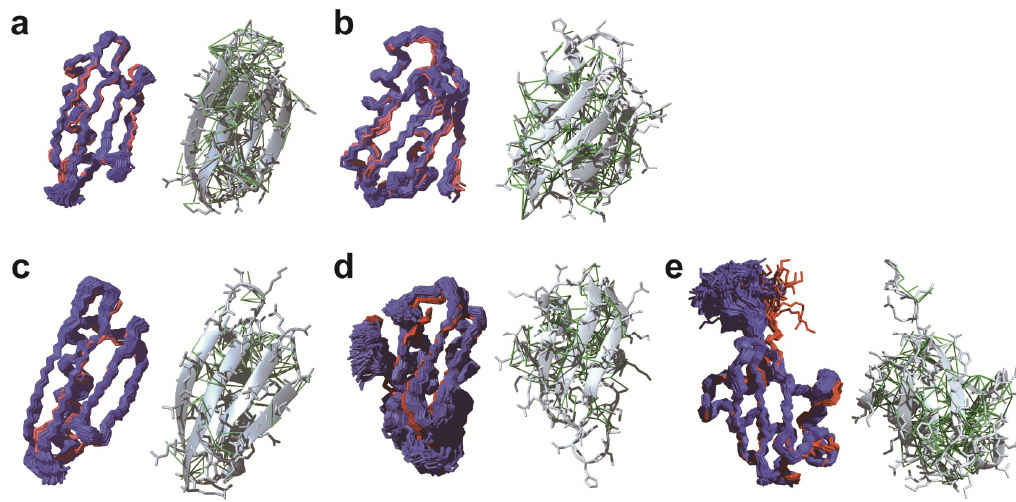
Figure 1. Protein structures determined by in-cell NMR. GB1 ( a ; PDB code: 2N9L) and TTHA1718 ( b ) structures in E. coli cells. GB1 ( c; 5Z4B), TTHA1718 ( d ; 6K1V), and ubiquitin 3A mutant ( e ; 6K1U) structures in sf9 cells. For all structures, the left panels show the backbones of the structure ensemble in cells (blue) and in diluted solution (red). The right panels show the best conformer in cells with side-chains (grey) and NOE distance restraints (green).